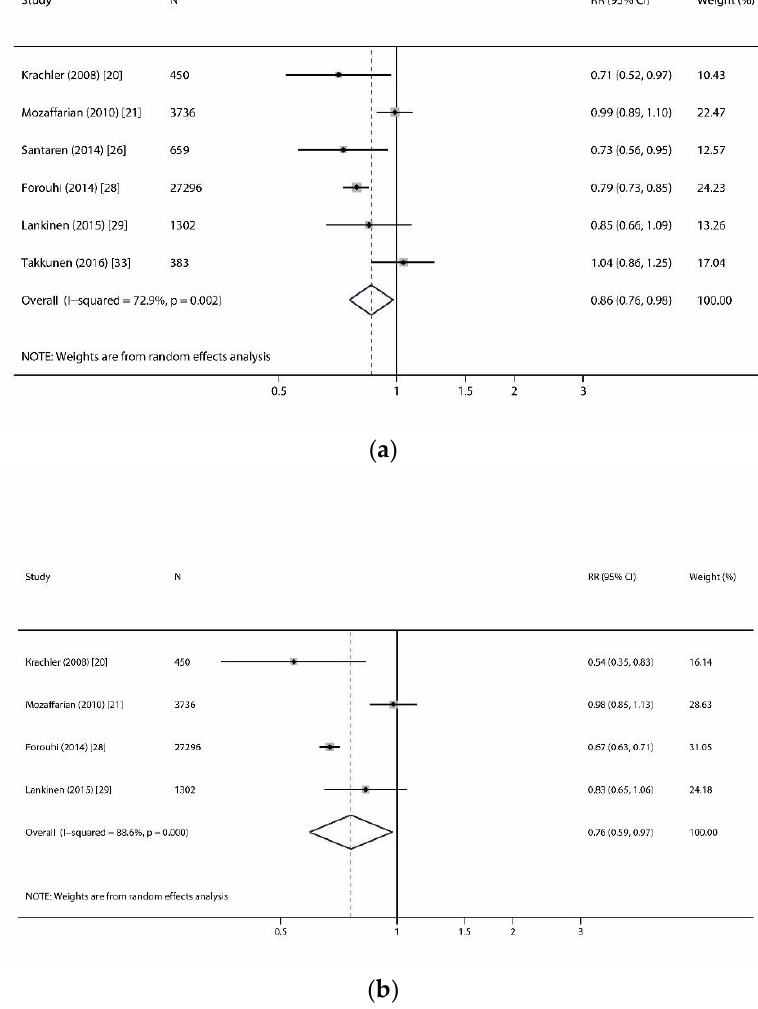
Figure 2. Forest plots of studies investigating the relationship of odd-chain saturated fatty acids and incident type 2 diabetes. ( a ) Forest plot for pentadecanoic acid (C15:0); ( b ) Forest plot for heptadecanoic acid (C17:0). RR: relative risk; CI: confidence interval.